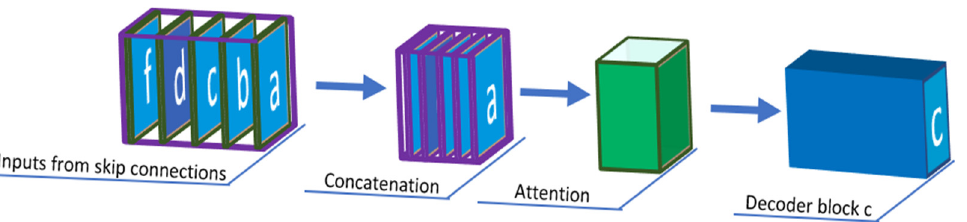
Figure 3. Output from encoder blocks A, B, C, and F and decoder block D are passed through skip connections to decoder block C. In between, the past features are concatenated and then filtered through attention module.